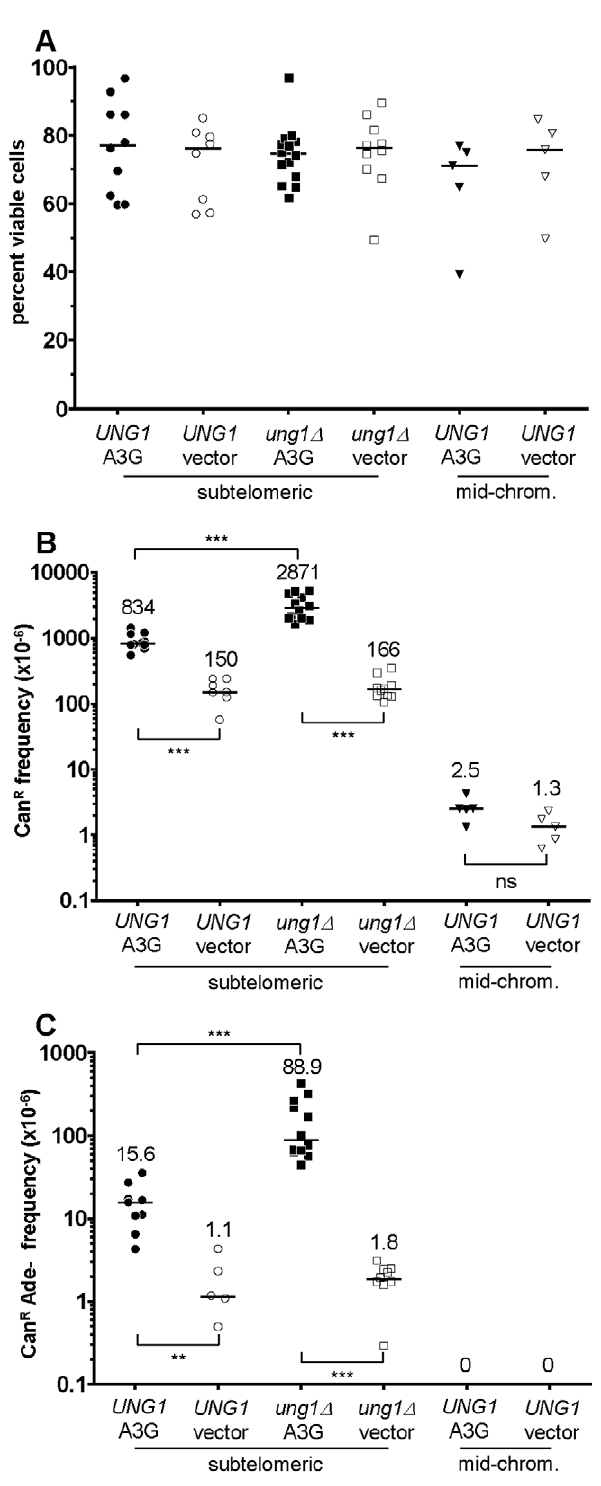
Figure 2. The activity of human APOBEC3G on the ssDNA mutagenesis reporter system. For all graphs: each data point represents the value from an independent experimental replicate; each bar represents the median value across all independent replicates of a given genotype and treatment combination; * denotes P , 0.05; ** denotes P , 0.01; *** denotes P , 0.001; and ns denotes P . 0.05. (A) Expression of human APOBEC3G from a tetracycline-regulatable plasmid was well-tolerated in reporter strains. Median viability was . 70%. (B) APOBEC3G induced an increased frequency of CAN1 loss